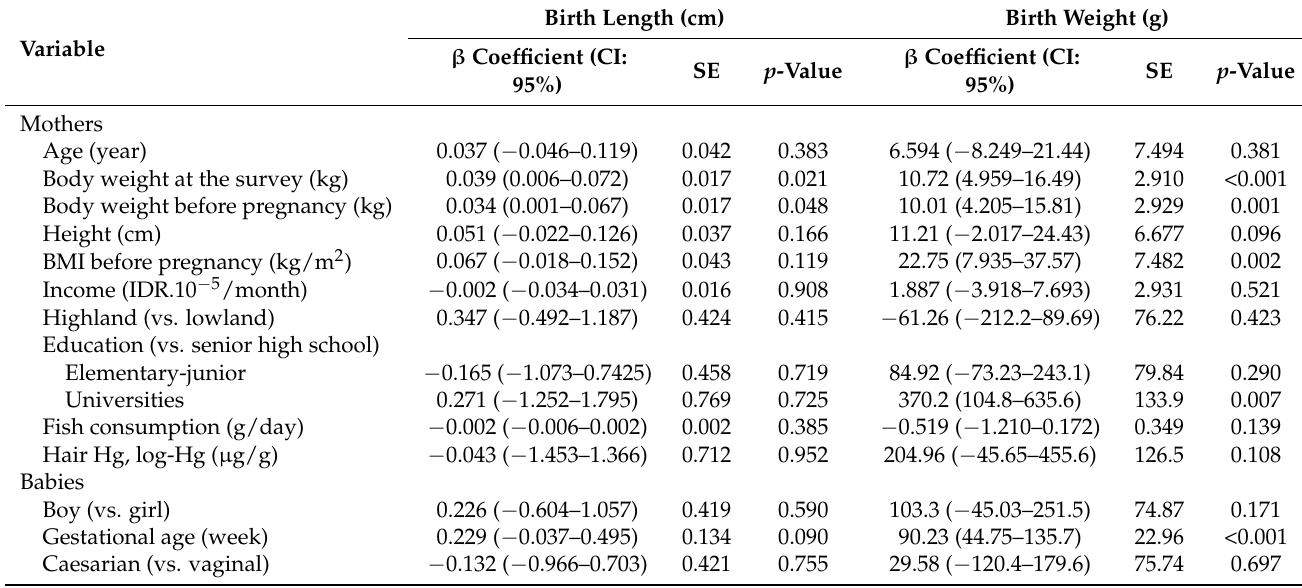
Table 4. Results of univariate regression analysis for birth length and weight of babies.